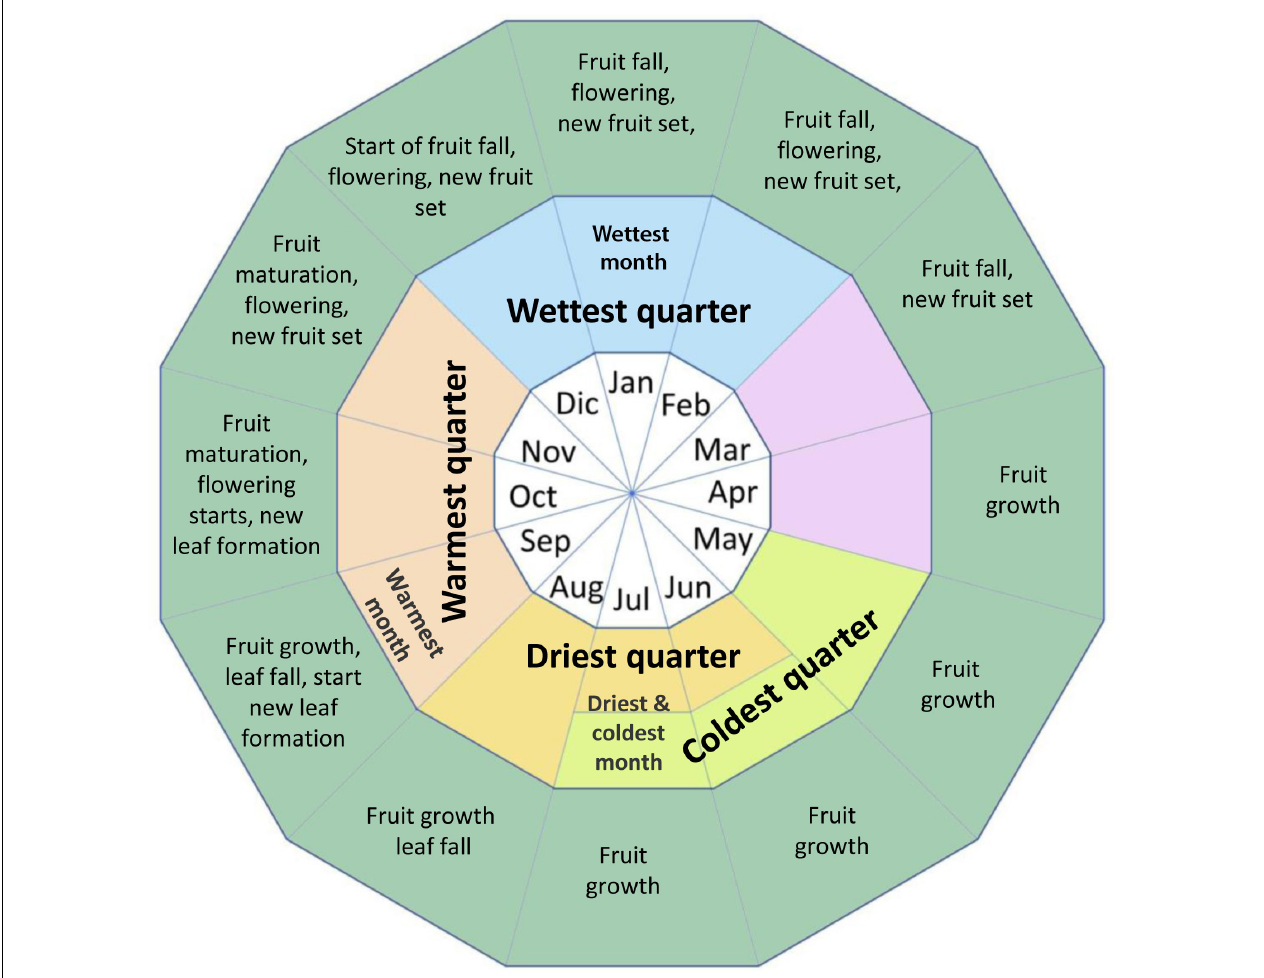
FIGURE 2 | Phenology of the Brazil nut in the study regions based on Corvera-Gomringer et al. (2010) and the authors’ personal long-term observations.